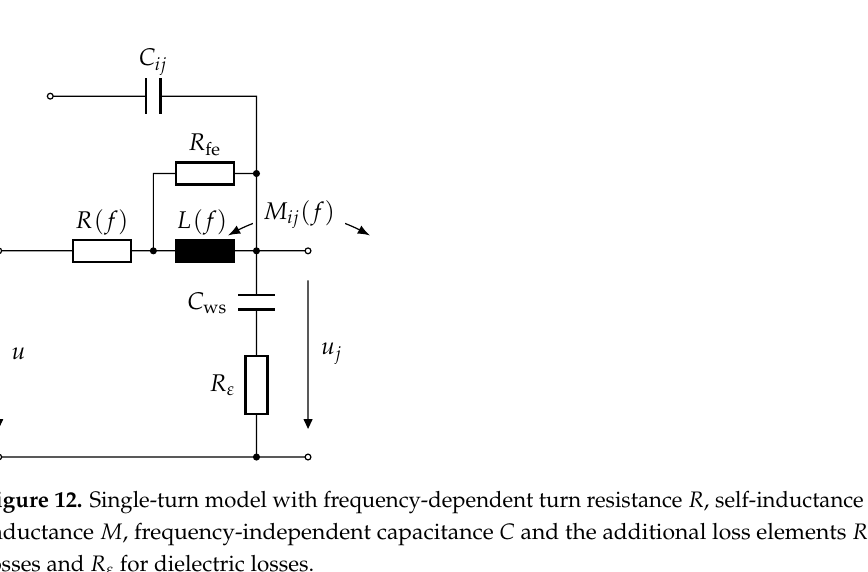
Figure 13. Measured and predicted turn-to-ground voltages for the first ten turns of stator specimen S3 with an input voltage gradient d u /d t = 30 V/ns